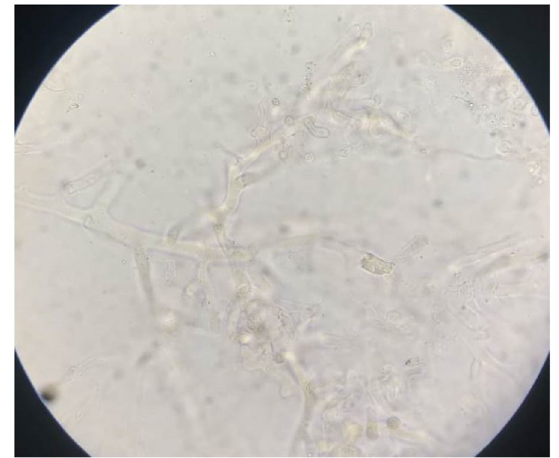
Fig. 3 KOH mount showing broad aseptate hyphae branching at wide